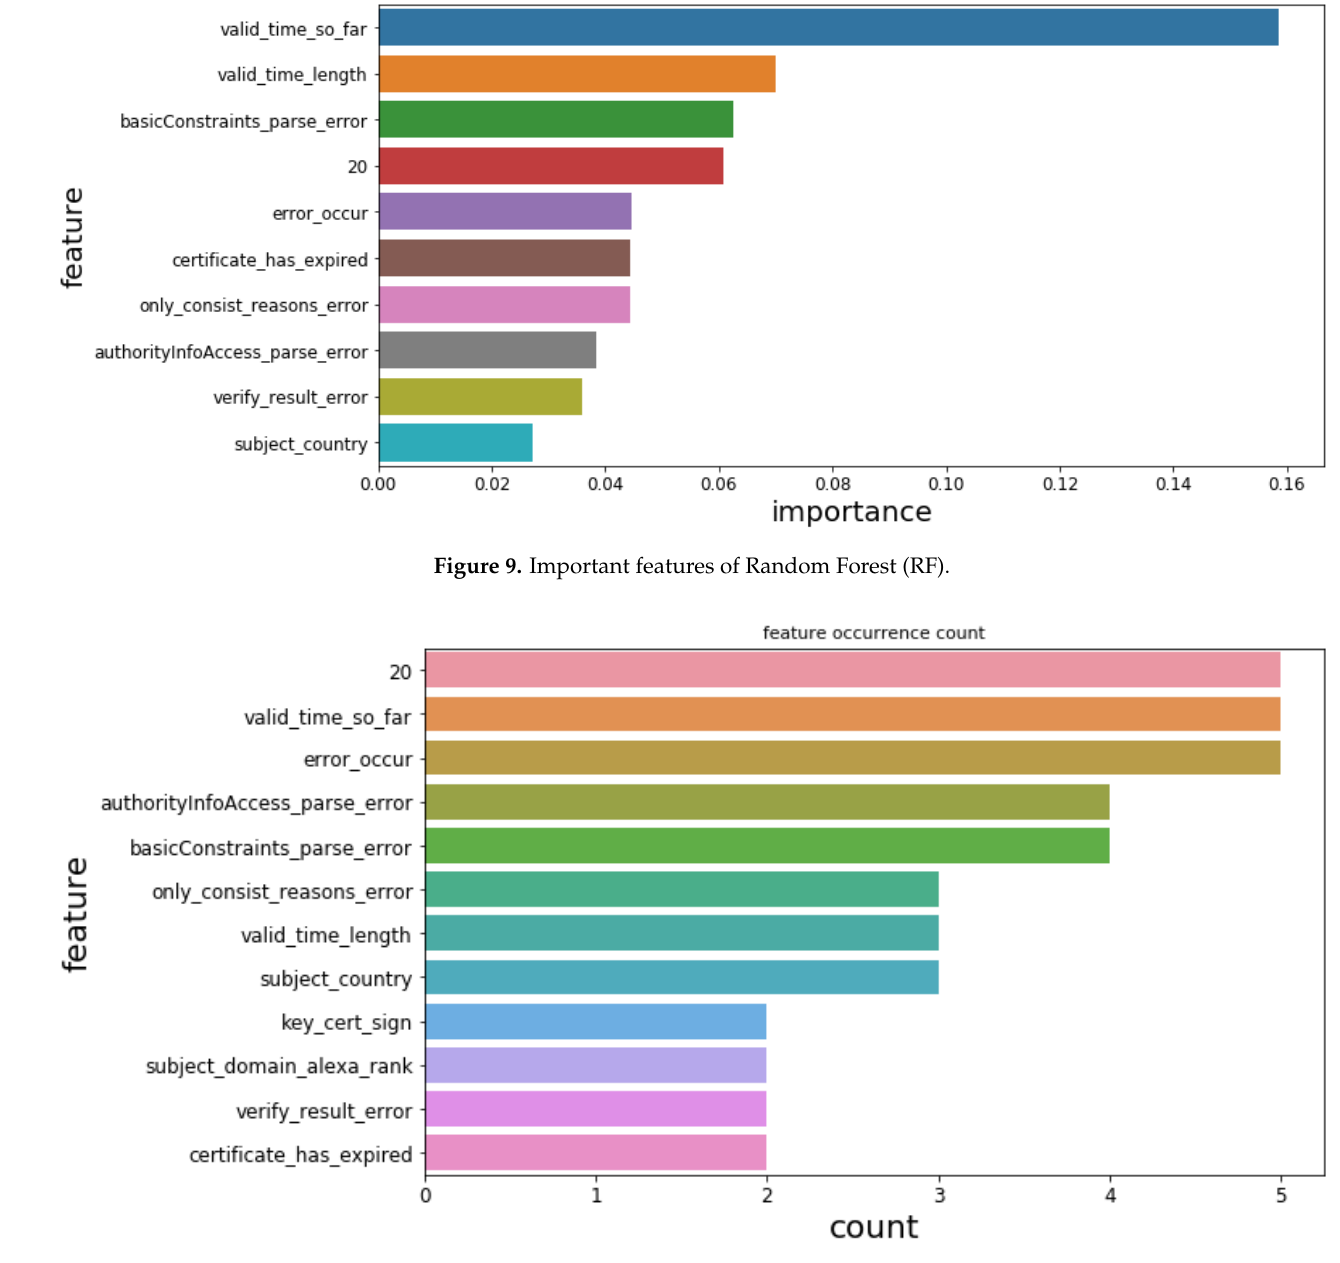
Figure 10. Feature occurrence count in top 10 important features of five